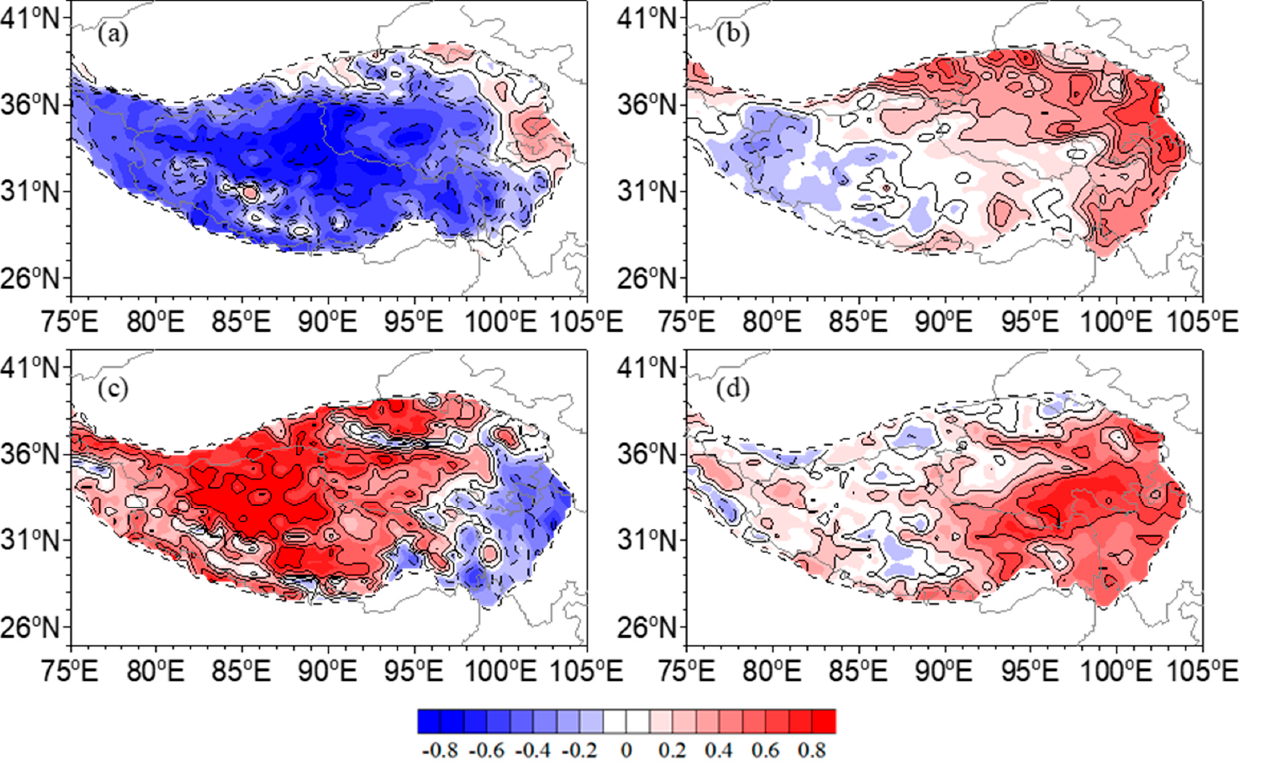
Figure 2. The spatial distributions of the eigenvectors of the first and second EOF modes of the spring snowmelt and snow depth over the TP: ( a ) the EOF1 spring snowmelt mode; ( b ) the EOF2 spring snowmelt mode; ( c ) the EOF1 spring snow depth mode; ( d ) the EOF2 spring snow depth mode.